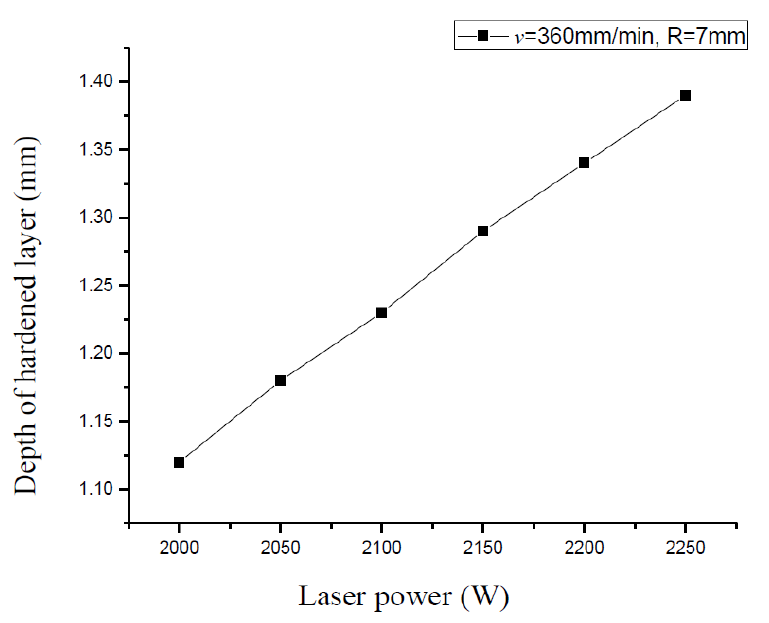
Figure 6. The relationship between different laser power and hardened layer depth.